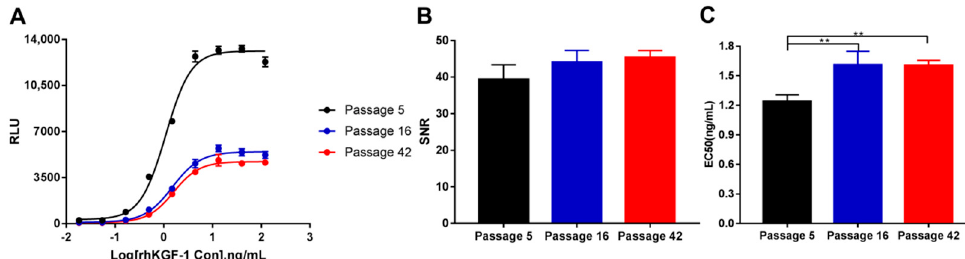
Figure 5. Stability of HEK293-Luc cell lines. ( A ) The responsiveness of HEK293-Luc cells to rhKGF-1 at different passages. ( B ) SNR of HEK293-Luc cells at three passages. ( C ) EC 50 of HEK293-Luc cells at three passages. RLU = Relative Luciferase Units. SNR = Signal-Noise-Ratio. The mean ± SD is shown on each curve. ** p < 0.001.